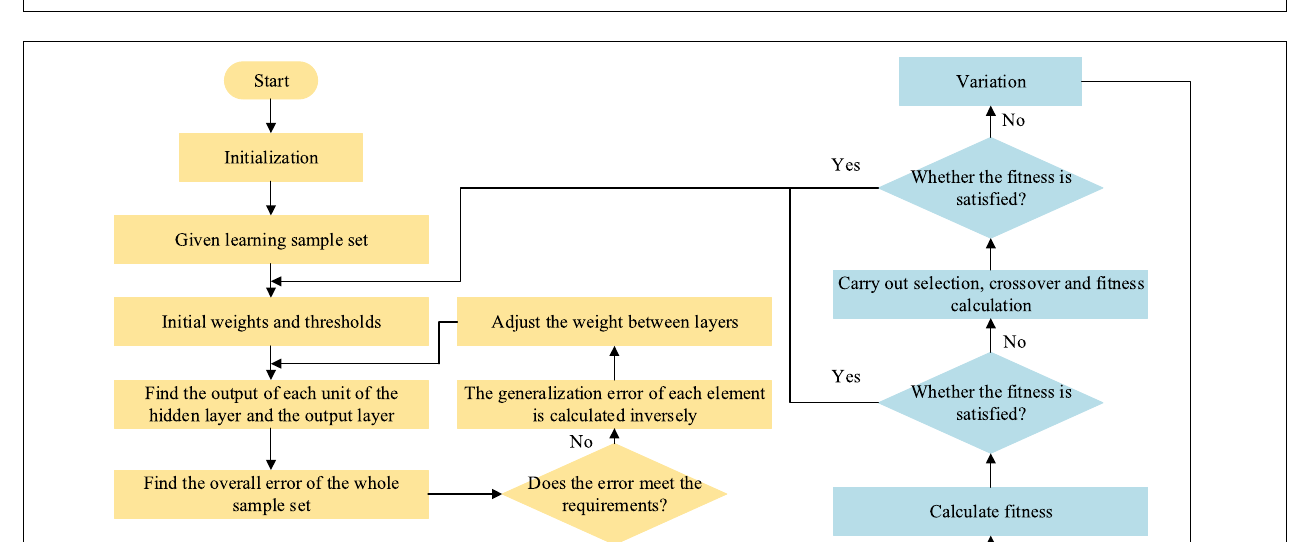
FIGURE 7 | Flow of GA.